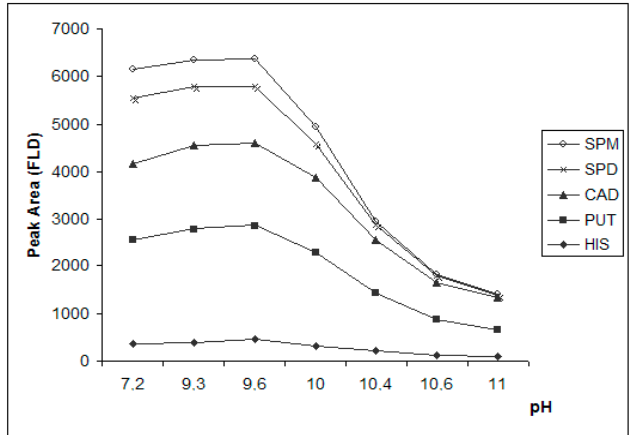
Figure 7. Effect of pH on the efficiency of the derivatization reaction of putrescine (PUT), cadaverine (CAD), histamine (HIS), spermidine (SPD) and spermine (SPM) in standard solution of 1 μ g mL − 1 with 400 μ L of 3 mM PSCl.